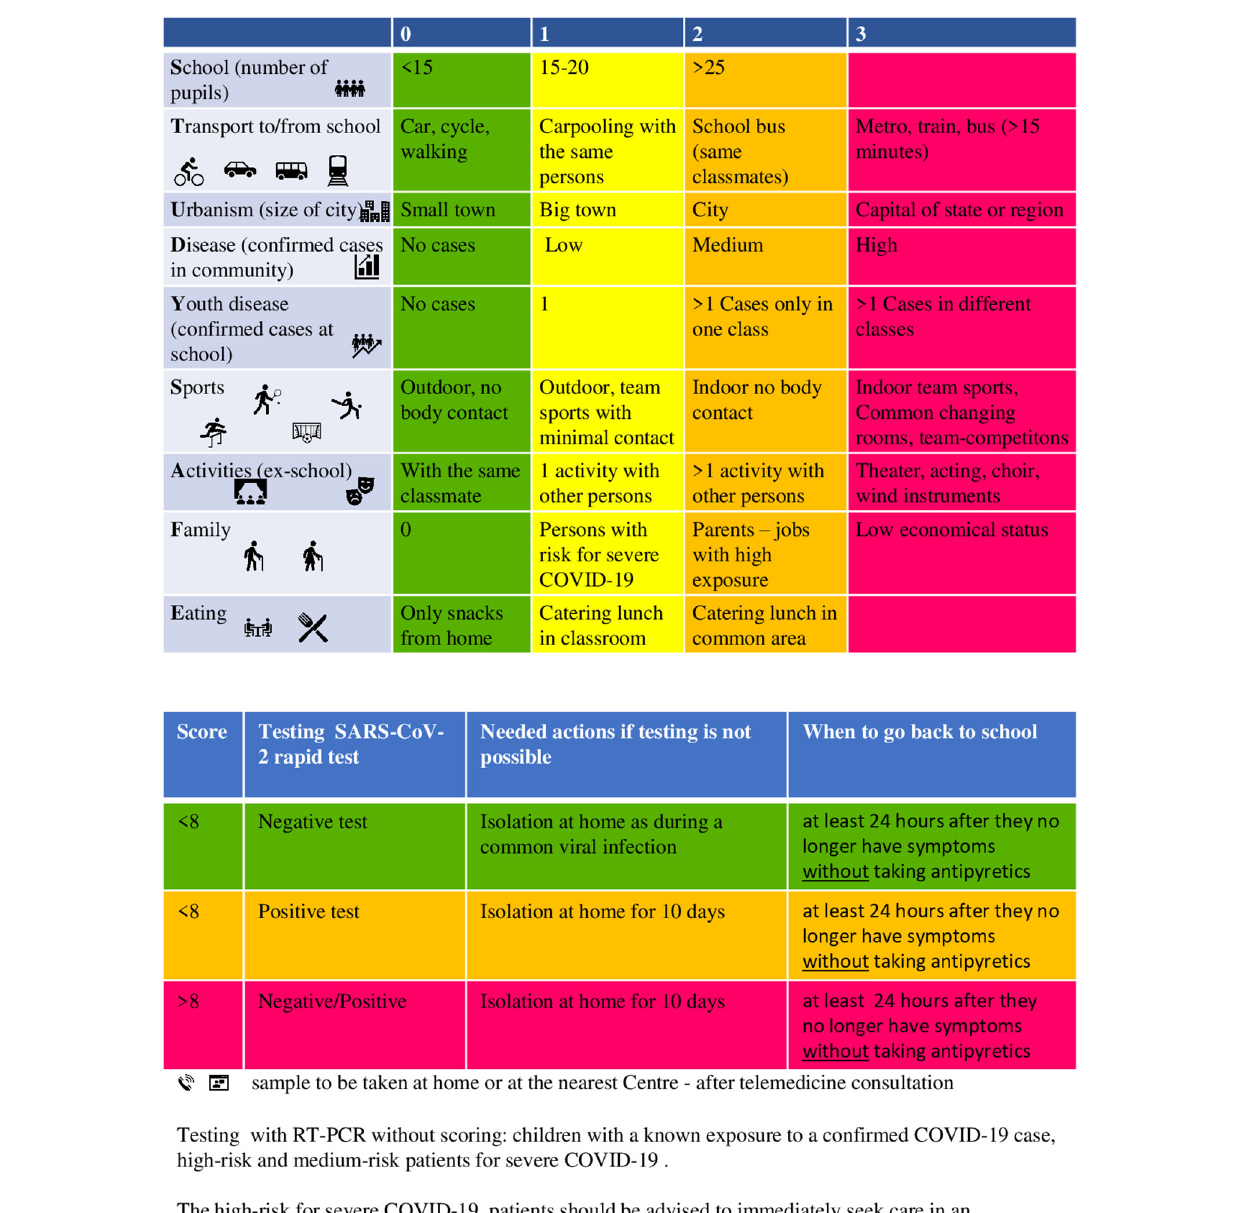
according to the severity of the symptoms (7); prior notification of the health care department is highly